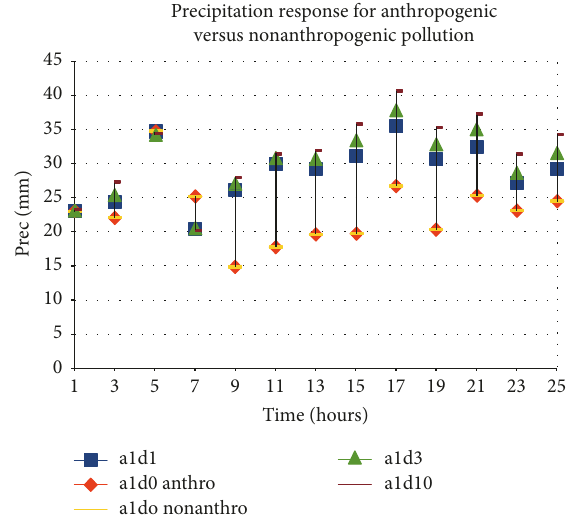
Figure 15: Plot of precipitation for (a) a1d1, (b) a1d0, (c) nonanthro- pogenic pollution aerosol, (d) a1d3, (e) a1d10.